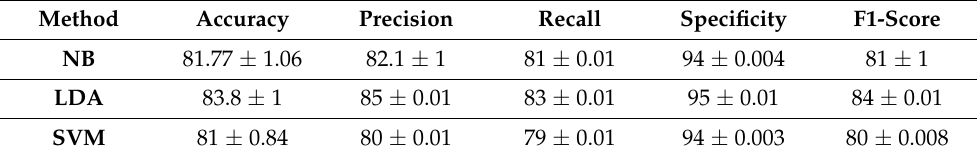
Table 1. Four-class classification performances of NB, LDA, and SVM algorithms when trained with fNIRS only features (i.e., GE cm and GE dm ). Each performance metric is represented in percentages (%) as the mean value across all runs ± standard deviation of the